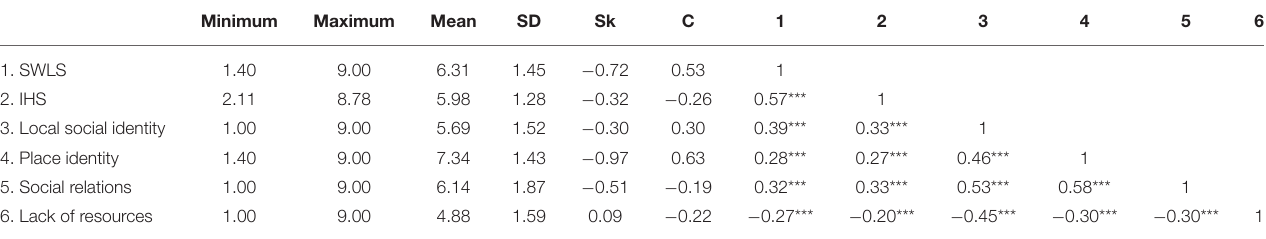
TABLE 2 | Means, SD, skewness, kurtosis, and zero-order correlations (Pearson’s r ) between variables ( N = 375). Minimum Maximum Mean SD Sk C